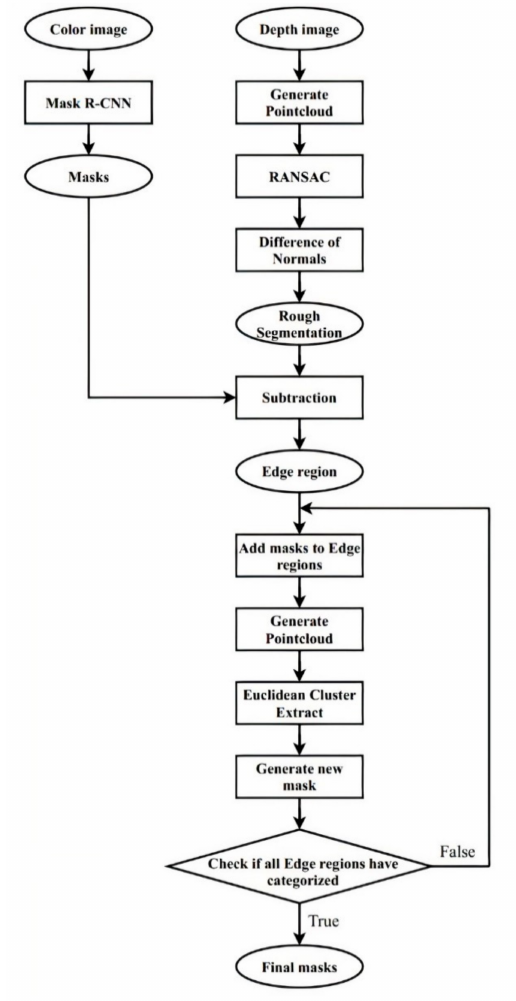
Figure 2. Flow chart of our approach for improving edge region